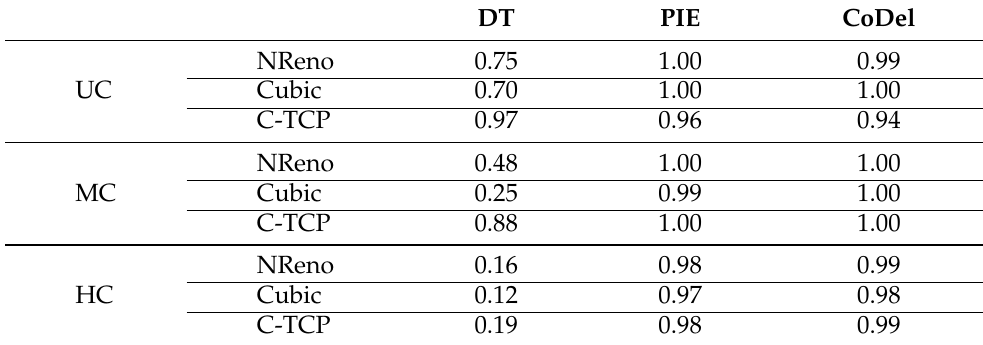
Table 3. Jain’s index (fairness) among long-lived flows in the Data center scenario with common TCPs, UC—uncongested, MC—mildly congested, HC—-heavily congested